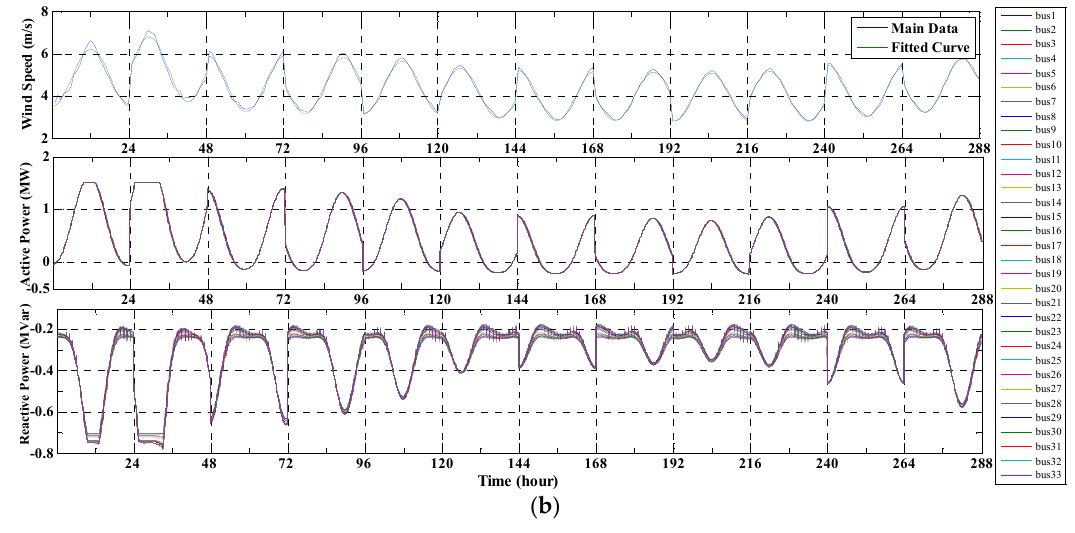
Figure 6. ( a ) Plots of all the monthly average diurnal Thevenin source voltage patterns for all the 33 buses in the 33-bus distribution network. ( b ) monthly average diurnal wind speed patterns, besides the patterns of active and reactive powers, injected by WDG when connected to each of the 33 buses in the network.